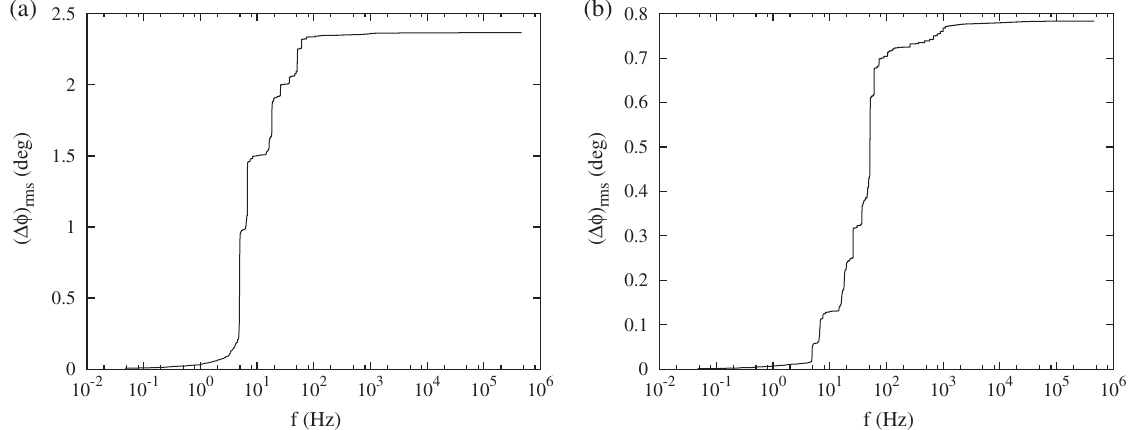
FIG. 8. Integrated magnitude spectra of phase error of the SEL with (a) amplitude and phase controllers deactivated and (b) both feedback loops closed.